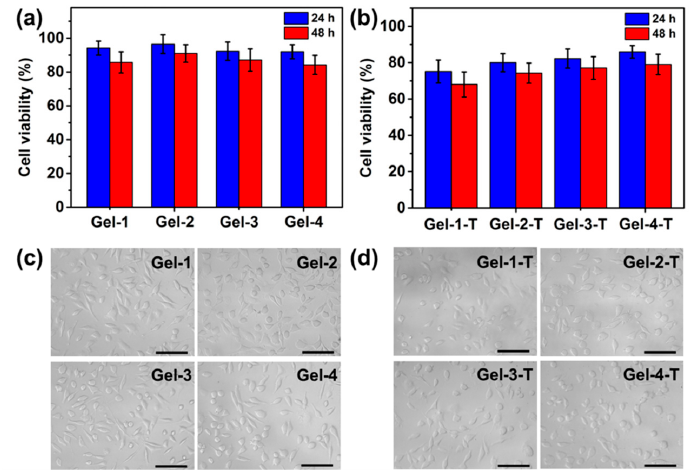
Figure 8. Cytotoxicity assay by the MTS method of ( a ) Gel-1, Gel-2, Gel-3 and Gel-4, and ( b ) triclosan-loaded Gel-1, Gel-2, Gel-3 and Gel-4 (labeled as Gel-1-T, Gel-2-T, Gel-3-T and Gel-4-T, respectively) after 24 h (blue bar) and 48 h (red bar). Cell images of the L929 cells in Dulbecco's modified eagle medium (DMEM) after 24 h incubating with ( c ) Gel-1, Gel-2, Gel-3 and Gel-4, and ( d ) Gel-1-T, Gel-2-T, Gel-3-T and Gel-4-T. Scale bars are 100 μ m.